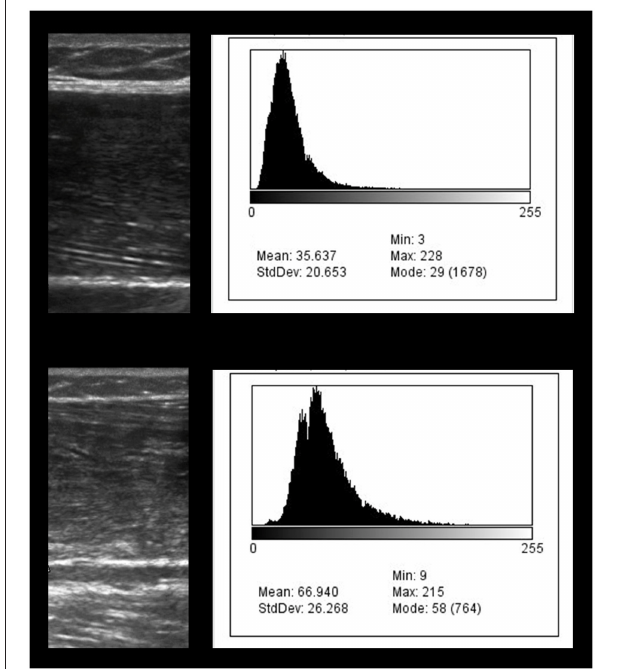
FIGURE 2 | Diagnostic ultrasound image of the rectus femoris region of interest and the corresponding grayscale histogram analysis values. The exemplar images depict the diagnostic ultrasound transverse muscle images on the left and the grayscale histograms on the right. The bottom ultrasound image shows greater hyperechoic properties in comparison to the top image. The comparatively hyperechoic image characteristics of the bottom image correspond to grayscale histogram data with a wider distribution and a shift to the right which is associated with larger grayscale values. The grayscale value of the bottom image is 66.9 and may indicate a greater proportion of intramuscular adipose tissue in comparison to the top image (grayscale value,